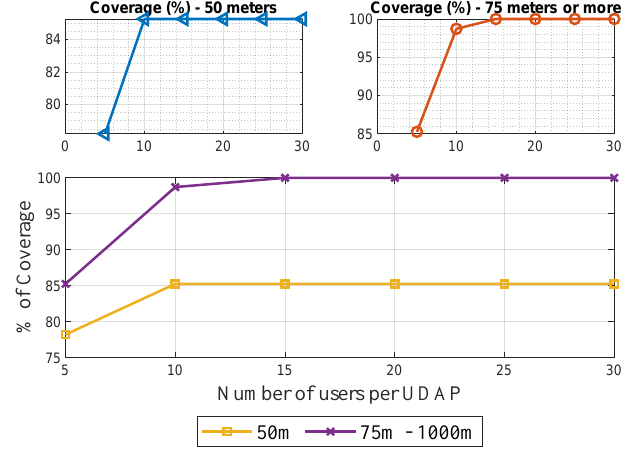
Figure 4. Percentage of devices covered—Greedy SCP.